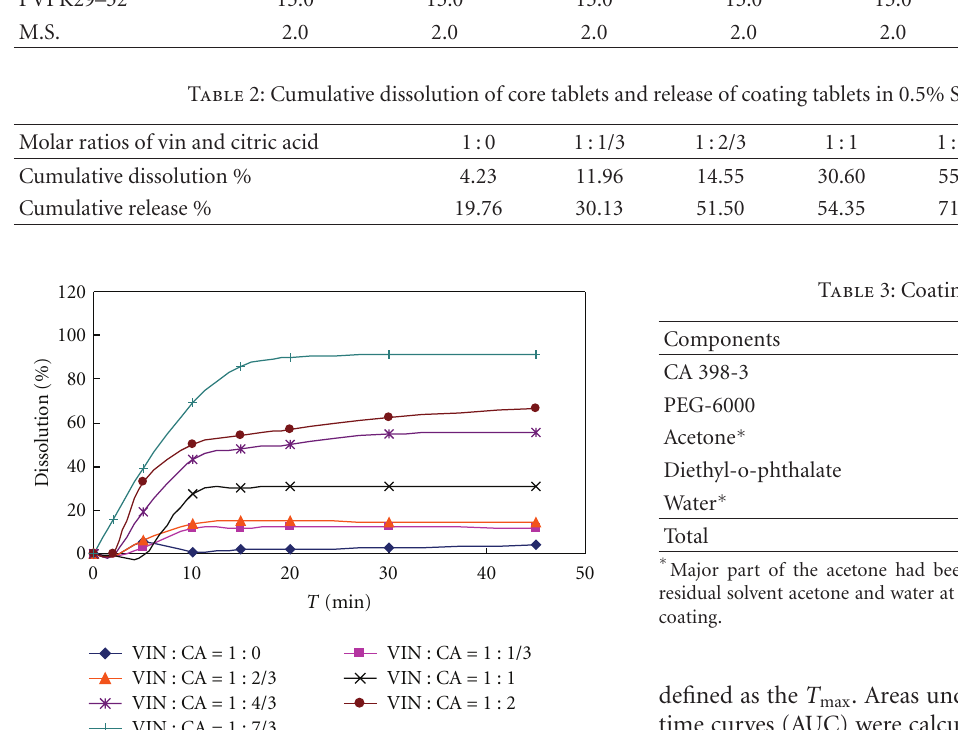
Figure 1: Influence of molar ratio of citric acid and vinpocetine on drug dissolution profile (core tablets in water dissolution media); VIN: vinpocetine; CA: citric acid.